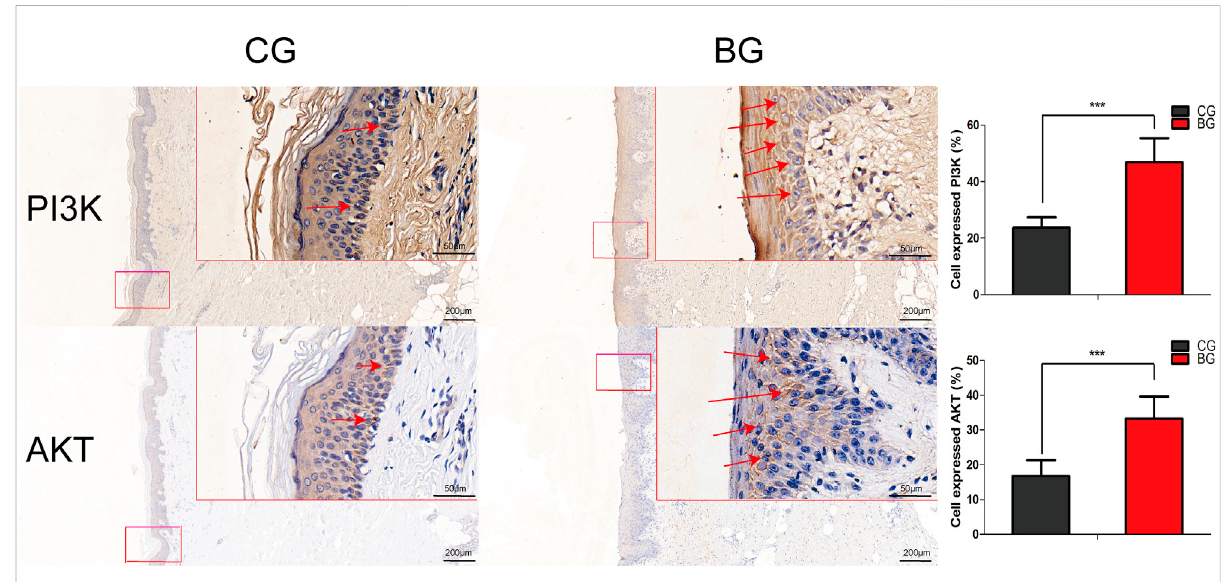
FIGURE 6 Immunohistochemical images of PI3K and AKT in normal and blistered skin. The number of cells expressing PI3K or AKT in the two groups was compared, and the expression of PI3K or AKT increased signi fi cantly in blister skin compared with normal skin. (Bars